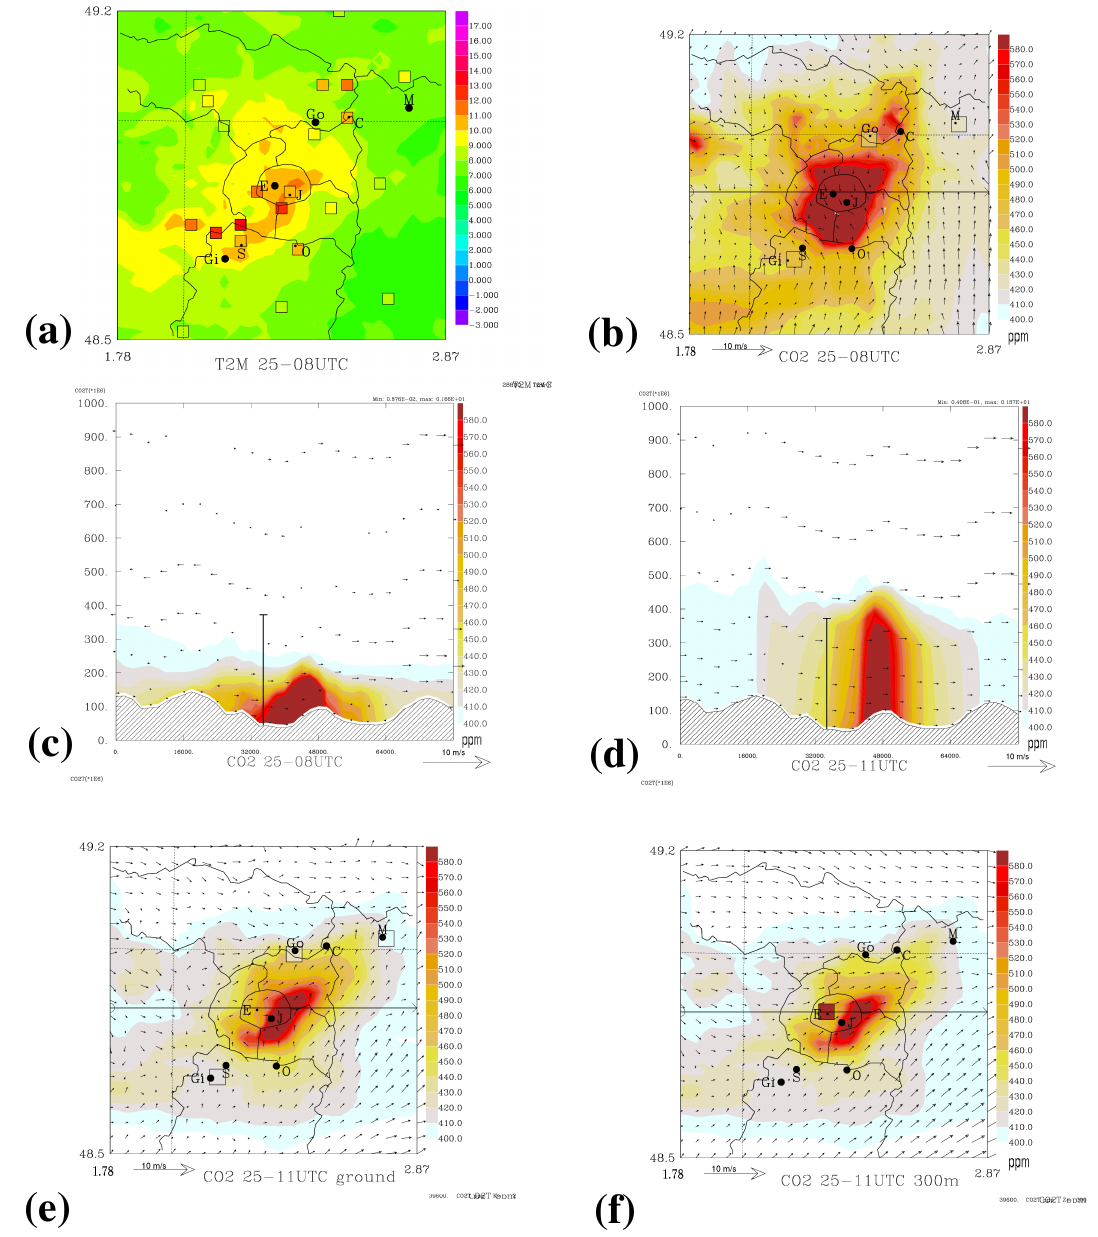
Fig. 13. MESO-NH predictions: for 25 March at 08:00UTC (a) 2m temperature (in ◦ C), (b) Horizontal cross section of CO 2 mixing ratio (in ppm) near the ground. (c) Vertical cross section of CO 2 mixing ratio (in ppm) according to the axis given in (b) for 25 March at 08:00UTC, and for 25 March at 11:00UTC (d) , with wind vectors superimposed. The Eiffel tower is symbolised by a stick, with a length corresponding to its measurement height. Horizontal ticks indicate metres. For 25 March at 11:00UTC: horizontal cross section of CO 2 mixing ratio (in ppm) near the ground (e) and at 300m height (f) with wind arrows superimposed. Coloured squares mean observed CO 2 mixing ratio.